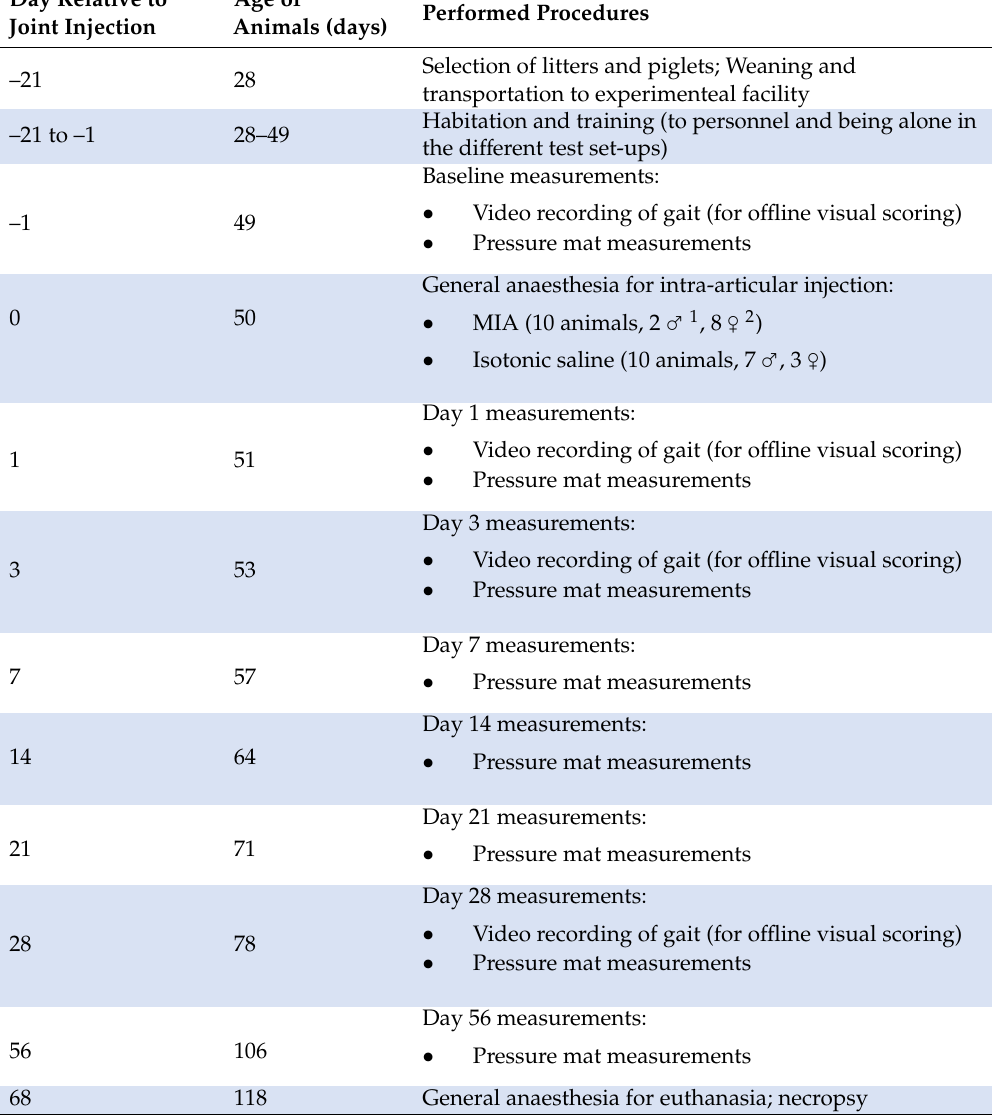
Table 2. Experimental